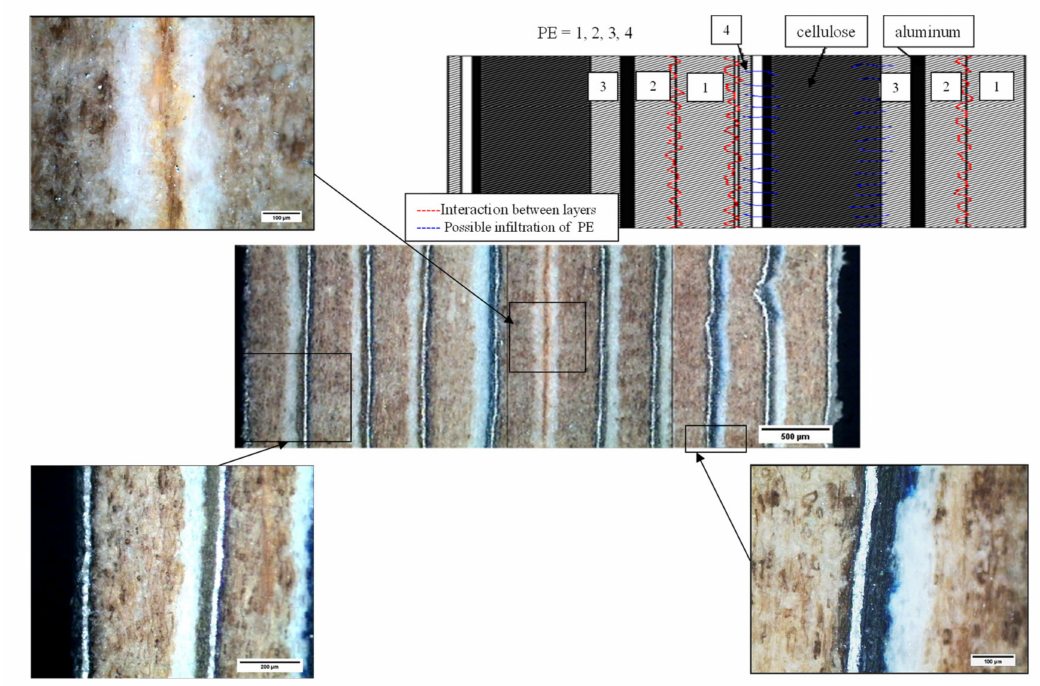
Figure 17. Basic micrograph of 10 sheets (G1). It shows di ff erent aleatory zones, and good adhesion between sheets can be observed. In the upper-right part, it shows a general draw of adhesion between two multilayer sheets (or